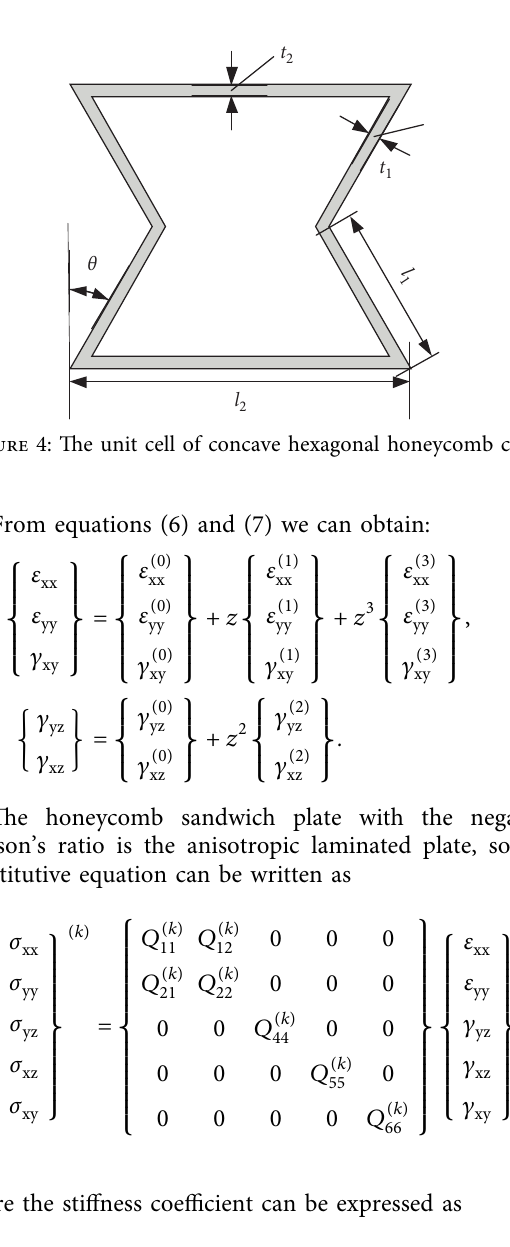
Figure 3: Type-B homogeneous faces sheet and FGH core.